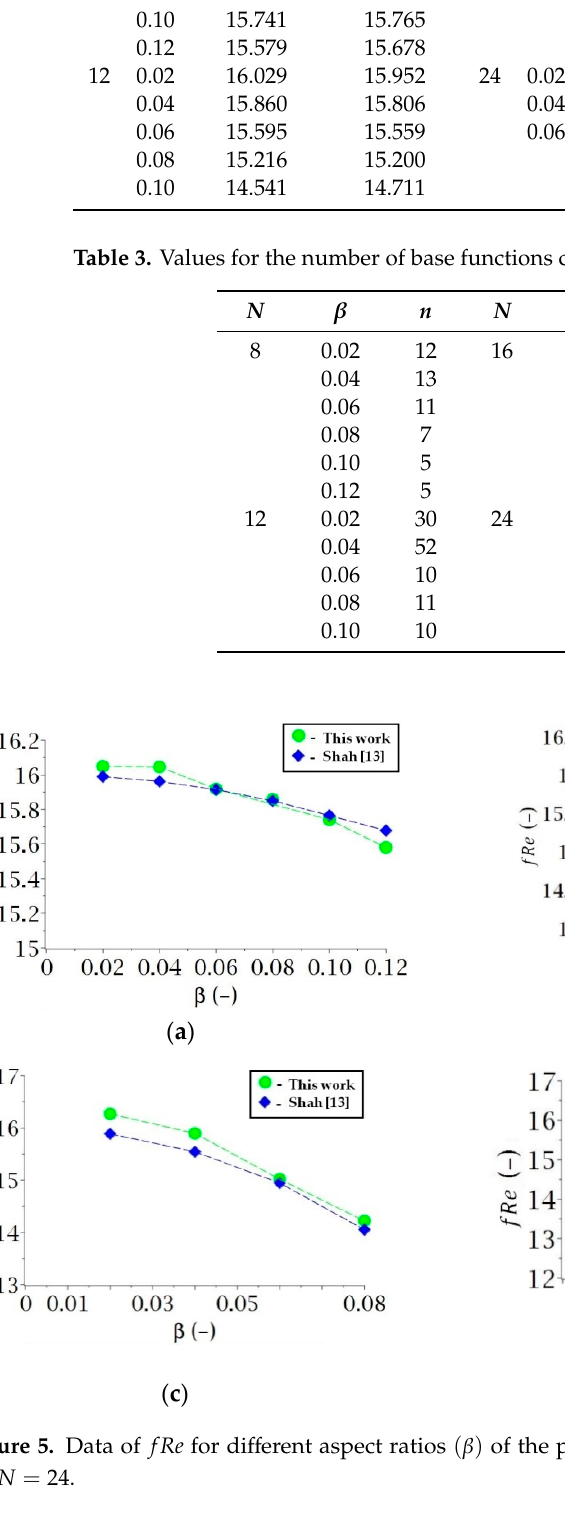
Table 11. Values of the fluid dynamic parameters obtained in the simulations with 𝛽 = 0.06 and 𝑁 = 24.